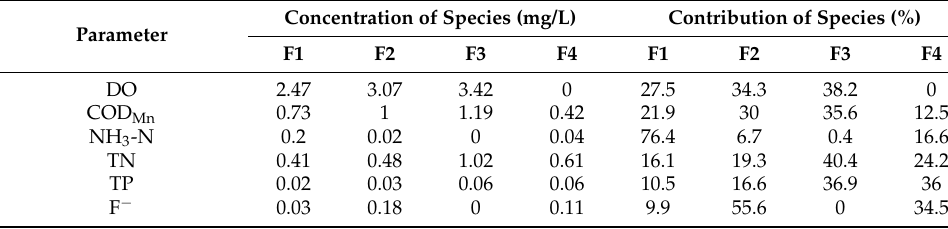
Figure 10. Source profile and contribution rate in the downstream. Table 9. Pollution source profile and contribution rate in the downstream